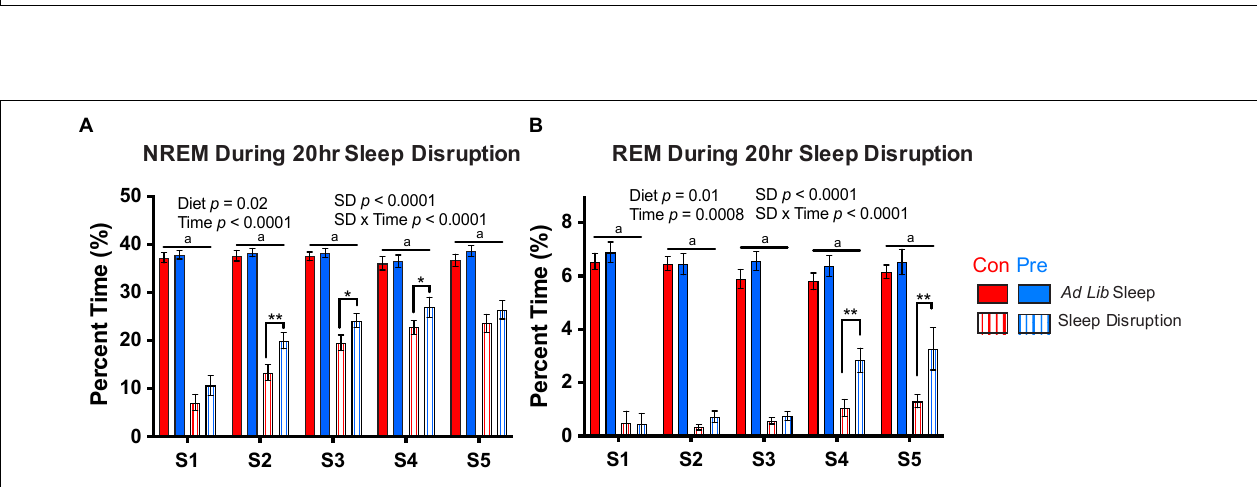
FIGURE 4 | The prebiotic diet increases sleep during the sleep disruption protocol. Rats were exposed to 5 days of sleep disruption achieved by a slowly rotating bar at the bottom of the cage for 20 h per day (ZT6-ZT2). Sleep was recorded throughout this protocol, and (A) NREM sleep and (B) REM sleep during the 20-h sleep disruption periods (S1-S5) are depicted above. Mixed-effect modeling testing for an effect of timepoint, diet, sleep disruption, and interactions was performed for each measure, and significant results are reported in the figure. Data are mean + SEM. Symbols: ** q < 0.01, * q < 0.05, Fisher’s LSD test with Benjamini-Hochberg correction for multiple comparisons; a q < 0.001 for all four within-timepoint pairwise comparisons between ad lib sleep groups and sleep disruption groups. Con, control diet; NREM, non-rapid eye movement sleep; REM, rapid eye movement sleep; Pre, prebiotic diet. n = 19–24/group.